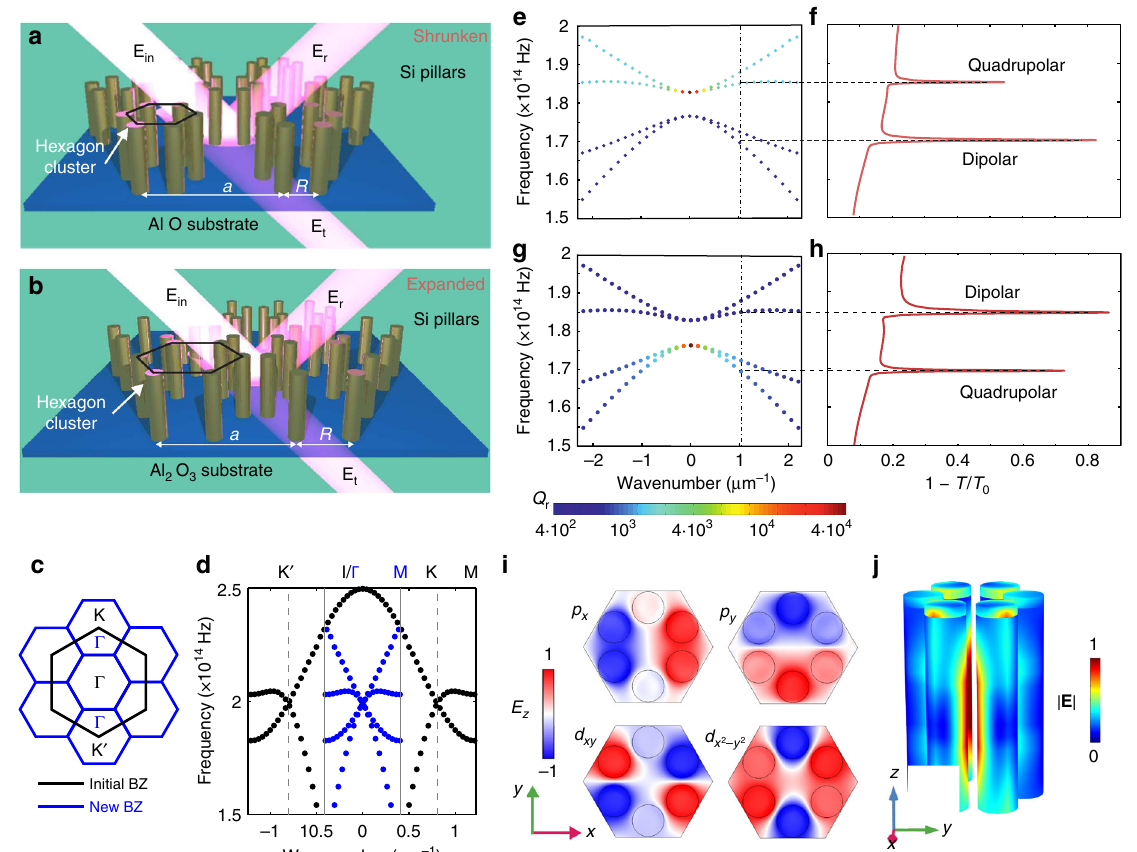
Fig. 1 Design of a photonic metasurface exhibiting topological transition and band inversion above the light line. a , b Geometry of a metasurface based on a triangular lattice of hexamers of silicon pillars on a sapphire (Al 2 O 3 ) substrate: a shrunken structure with a / R > 3; b expanded structure with a / R < 3. Here a is the lattice constant of distorted lattices. E in , E r , and E t , are incident, re fl ected and transmitted fi elds. c Brillouin zone of an unperturbed honeycomb lattice a / R = 3 (black) and the triangular lattice under study a / R ≠ 3 (blue) obtained by the honeycomb lattice deformation. d Band structure of (in fi nitesimally) shrunk/expanded hexamers exhibits folding (of black dotted bands) near K and K ′ points to Γ point in the new Brillouin zone (blue dotted bands). As a result of such symmetry reduction, valleys (pseudo-spins) mix, which leads to a topological transition. e – h Demonstration of band inversion: Complex photonic band structure for the four doublet bands of e shrunken a / R = 3.15 and g expanded a / R = 2.85, structures. Color encodes the radiative quality factor of the modes. Calculated extinction spectra 1 − T / T 0 of the shrunken ( f ) and expanded ( h ) metasurfaces. Spectra are normalized to the transmittance T 0 through Al 2 O 3 substrate and are computed for fi xed tangential wavenumber k || = 1.04 × 10 6 m − 1 . The peaks in far- fi eld spectra correspond to the eigenmode frequencies for the given tangential wavenumber. i Simulated fi eld pro fi les showing the E z fi eld component at the top surface of the unit cell for dipolar ( p x and p y ) and quadrupolar ( d xy and d x 2 (cid:2) y 2 ) eigenmodes for expanded (topological) structure. j Side view of the fi eld distribution in the unit cell under resonant excitation of the dipolar mode for the normal incidence of x -polarized light. Electric fi eld magnitude is normalized to the maximum ~ shows the color map of the quantity R ¼ 1 (cid:2) T = T 0 as a function